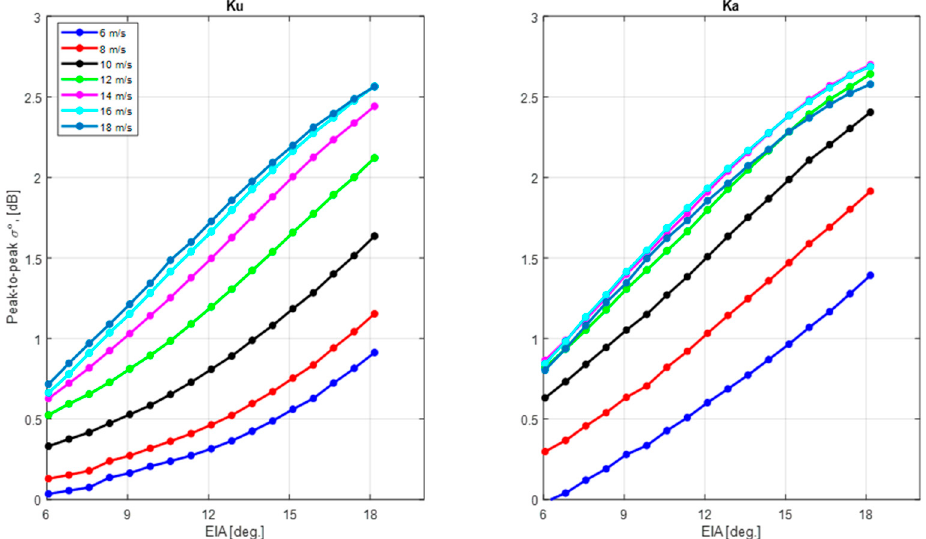
Figure 19. Peak-to-peak KuPR ( left ) and KaPR ( right ) downwind/crosswind σ 0 anisotropy as a function of EIA for different WS values.